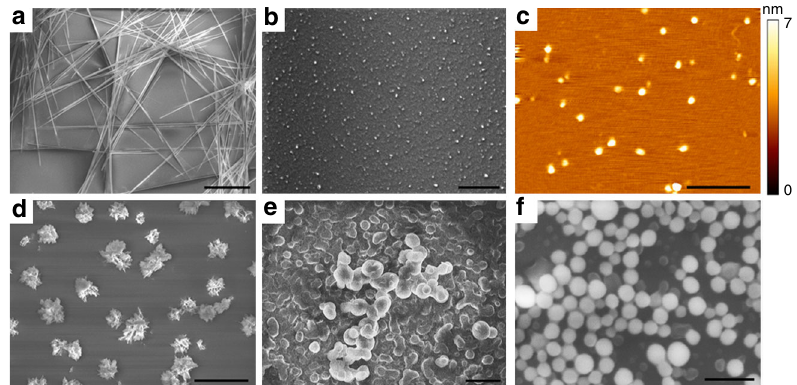
Fig. 3 SEM and AFM images of the cyclo-dipeptides QC self-assemblies in MeOH. a Needle-like cyclo-FW crystals., Scale bar: 40 μ m. b Spherical cyclo- WW nanoparticles, Scale bar: 20 μ m. c Dimeric QDs of cyclo-WW + Zn(II), Scale bar: 500 nm. d Nano- fl ower architectures of cyclo-F w , Scale bar: 20 μ m. e and f Larger spherical nanoparticles of ( e ) cyclo-WW + Cu(II) and ( f ) cyclo-WW + UV. Scale bar: 2 μ m